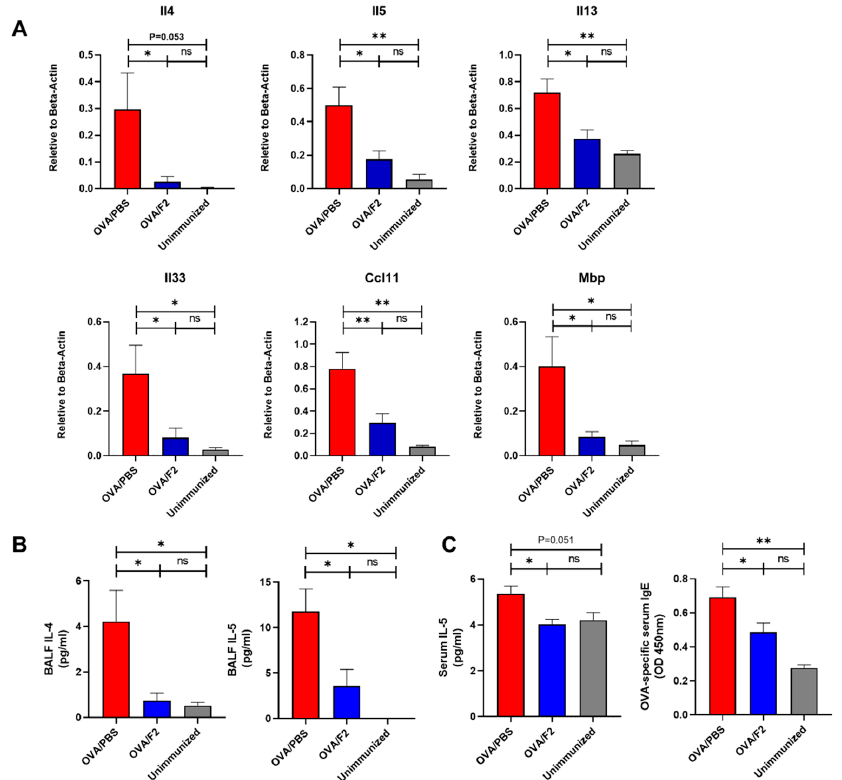
Figure 4. Administration of mAb F2 suppressed the allergic immune response in the lungs and serum. ( A ) The mRNA expression in the lung of IL-4, IL-5, IL-13, IL-33, CCL11, and MBP was examined using quantitative-PCR. Samples from 2 independent experiments were examined. ( B ) The concentration of the Th2 cytokine IL-4 and IL-5 in the BALF was determined by ELISA. ( C ) The concentration of IL-5 and the amounts of OVA-specific antibodies in the serum were determined using ELISA. The experiment was repeated twice independently. * p < 0.05, ** p < 0.01. A p -value of less than 0.05 was considered